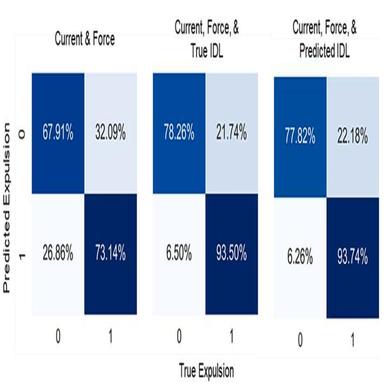
Predicted vs. true expulsion confusion matrices for all input combinations: 0 represents normal welds and 1 represents expulsed welds.